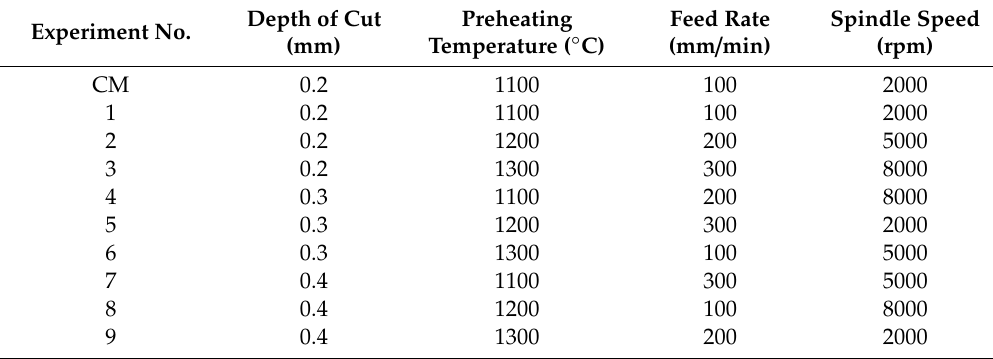
Table 5. The experimental layout using an L 9 orthogonal array.